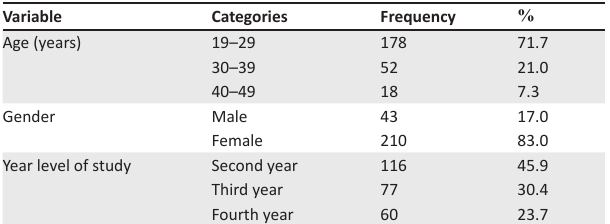
TABLE 1: Age, gender and year of study (sample size n = 253).